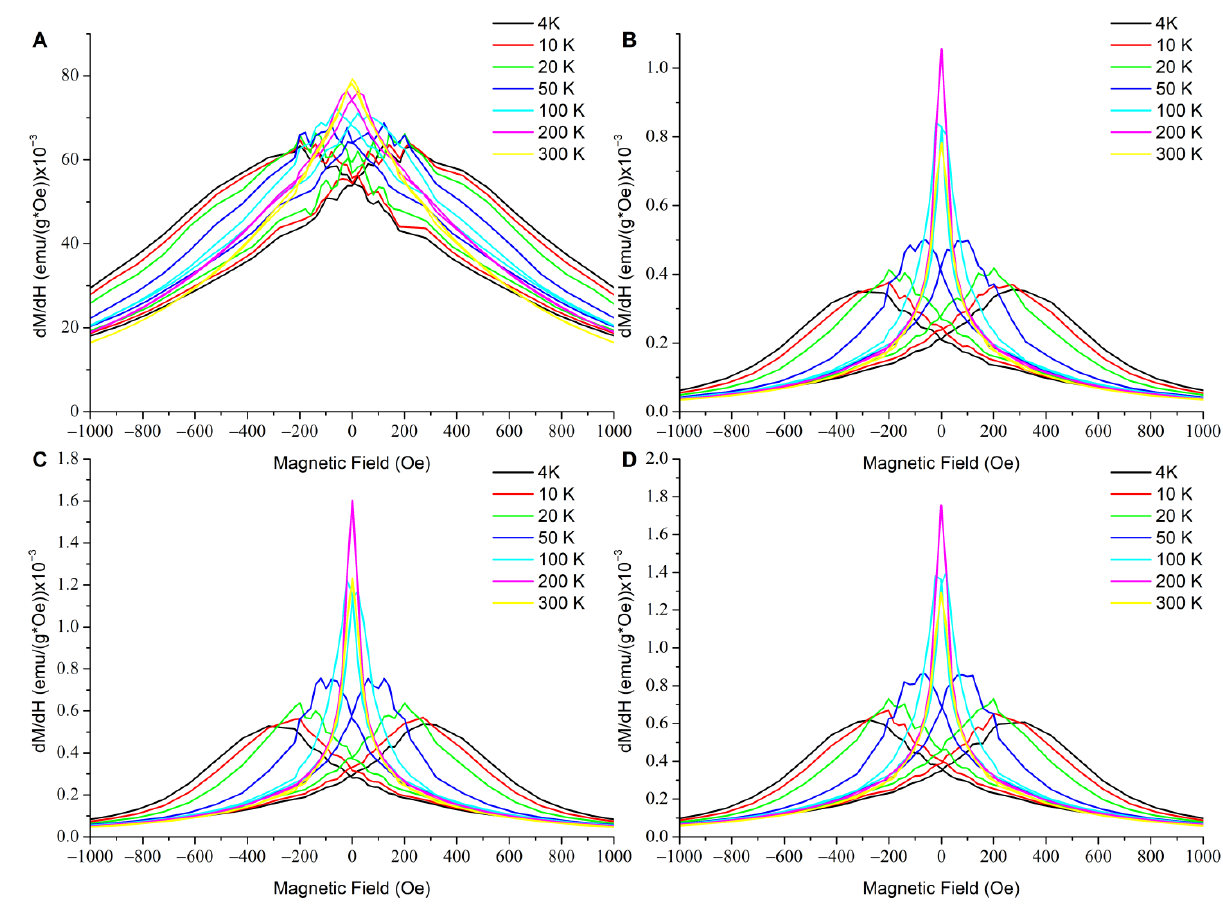
Figure 3. Derivatives of the magnetization curves (i.e., differential susceptibilities) for the materials studied: SPIONs ( A ), ColCh 0:100 S1 ( B ), 25:75 S1 ( C ), and 50:50 S1 ( D ) at different temperatures.